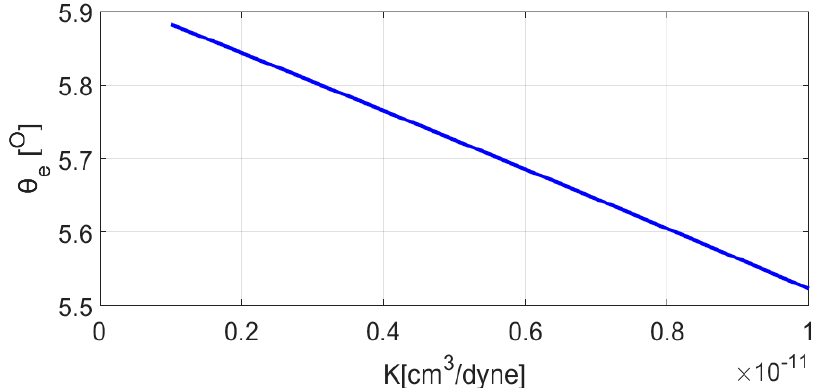
Figure 7. Equilibrium contact angle, θ e , vs elasticity coefficient, K . Reproduced with permission from [19]. Copyright © 2018 American Chemical Society.